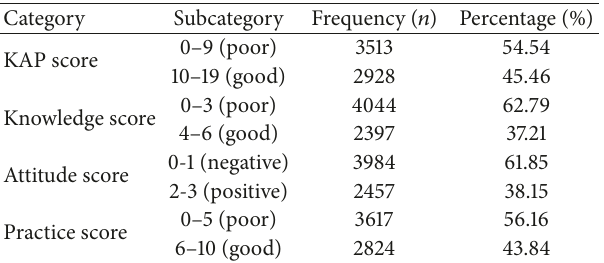
Table 2: Distribution of the MNT, knowledge, attitude, and practice